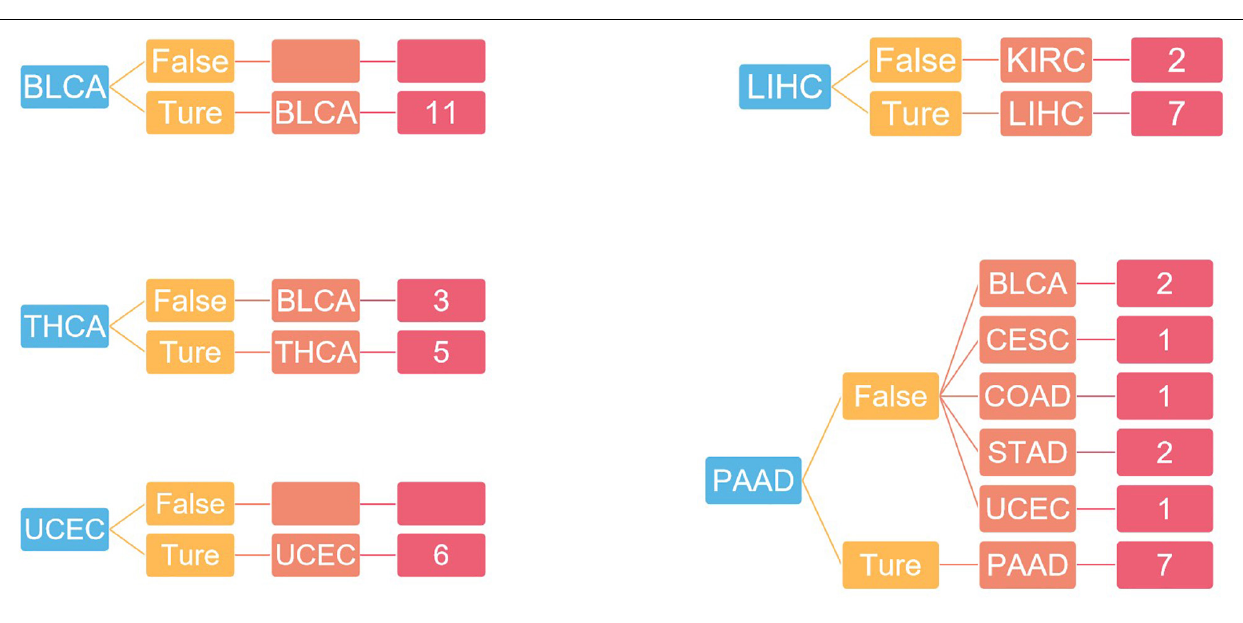
GSE5608, GSE8352, GSE4895, GSE8912, GSE7966,